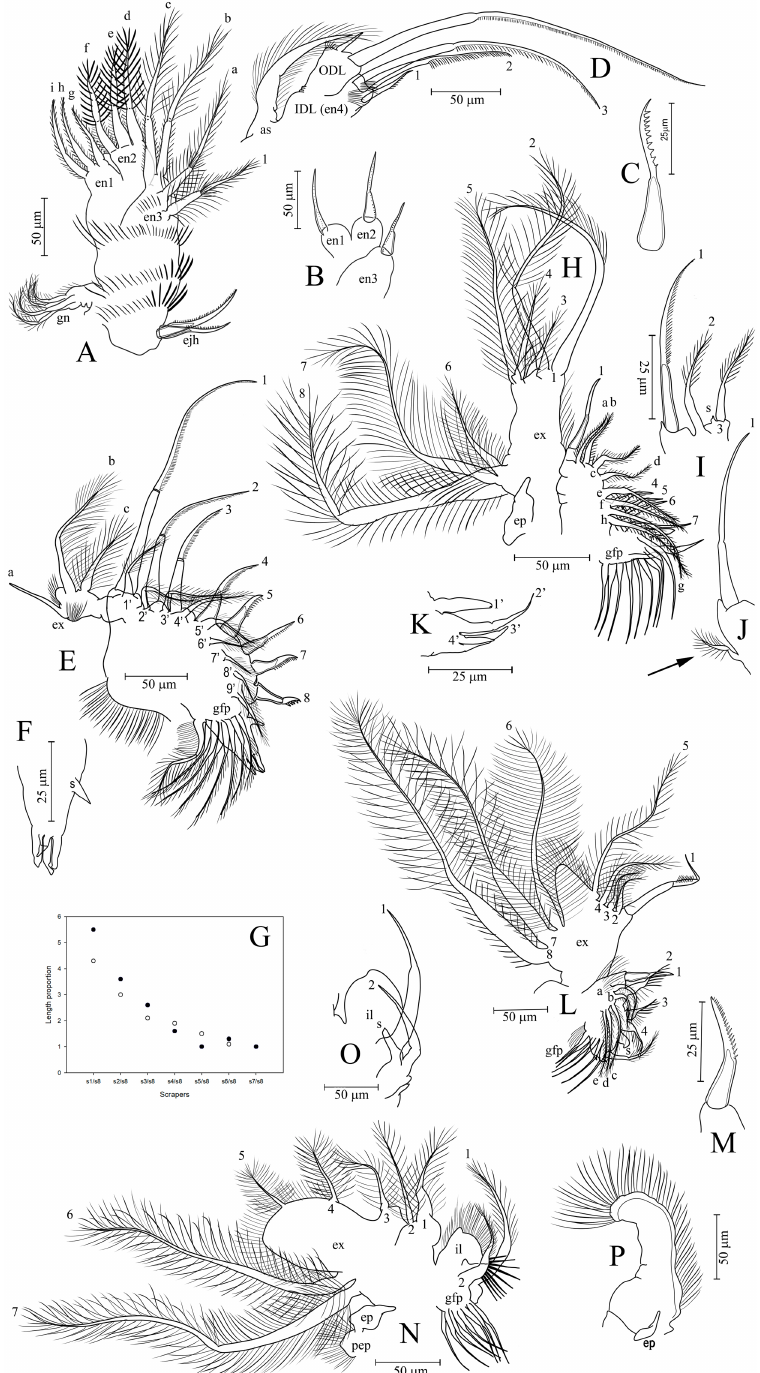
Fig. 3. Acantholeberis accolismaris Sousa, Elmoor-Loureiro & Álvarez-Silva sp. nov., parthenogenetic female from the Planície Costeira, Rio Grande do Sul (FDRS0696). A . First limb. B . Idem, endites and stiff setae. C . Idem, morphology of stiff setae of endites. D . Inner distal lobe and outer distal lobe. E . Second limb. F . Idem, gnathobase. G . Idem, comparative system of proportion of scrapers, white circles represent A. smirnovi Paggi & Herrera-Martinez, 2020 and black circles represent A. accolismaris sp. nov. H . Third limb. I–J . Idem, distal endite, arrow indicating the posterior seta. K . Idem, ganathobase. L . Fourth limb. M . Idem, seta 1 of distal endite. N . Fifth limb. O . Idem, inner lobe. P . Sixth